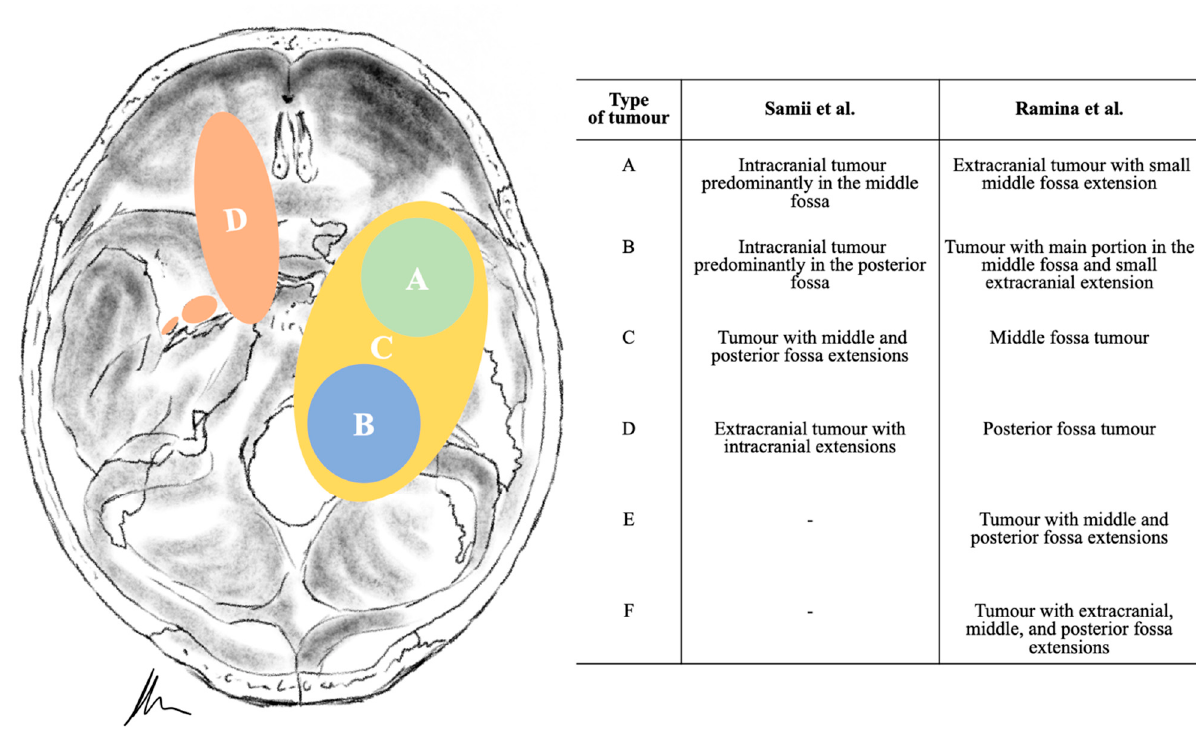
Figure 2. Illustration (according to Samii) and overview of the classification systems of trigeminal schwannomas.